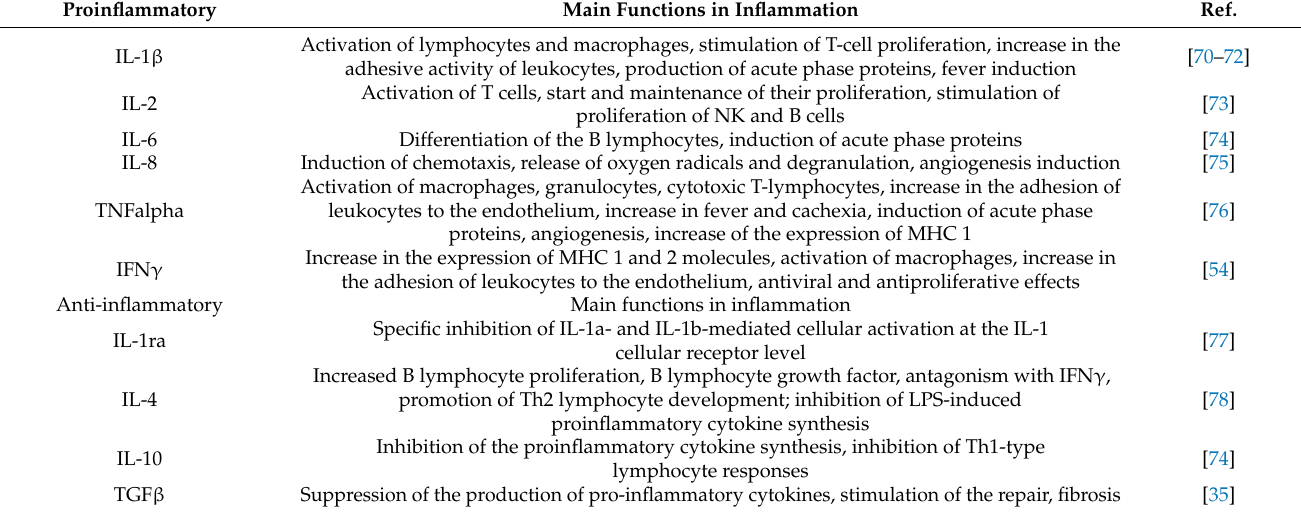
Table 2. Progesterone-regulated proinflammatory and anti-inflammatory cytokines. Proinflammatory Main Functions in